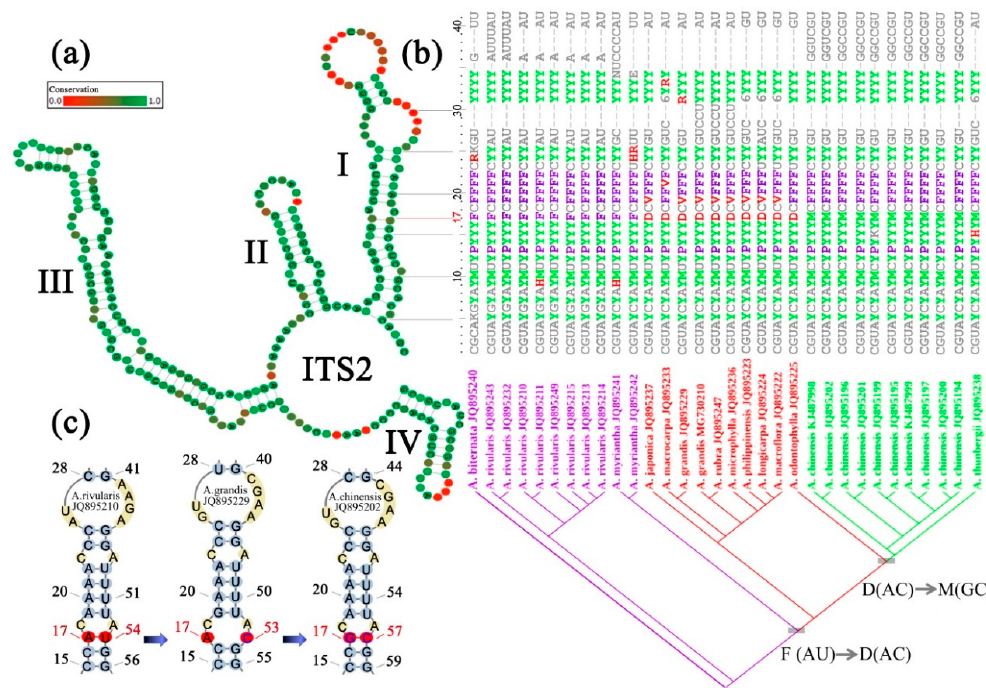
Figure 2. Transformation, visualization and optimization of compensatory base change in ITS2 secondary structure. ( a ) An ITS2 consensus secondary structure derived from closely related species of Astilbe . The four stems are labelled I–IV. Degree of site conservation over the entire alignment is displayed in colored grades from green (conservative) to red (variable). ( b ) A transformed coding matrix of sequence-structure information from portion of ITS2 stem I region. Base-pair information of ITS2 secondary structure ( a ) is coded and merged into a single character by using a modified 28-symbol coding matrix [40], wherein characters involved in CBC (compensatory base change) and hemi-CBC substitutions are highlighted in di ff erent colors, i.e., UA(P)-UG(R)-CG(Y), UA(P)-CA(H)-CG(Y), AU(F)-GU(V)-GC(M), AU(F)-AC(D)-GC(M). Character positions in the transformed matrix are corresponding to the ITS2 stem I one by one. Species of each sequence and their phylogenetic relationships are shown below. Base-pair states of site 17 are indicated using di ff erent colors in the matrix and are mapped and optimized on the tree to exemplify an unambiguous CBC process. ( c ) Representative sequence-structures showing di ff erent base-pair states of site 17. Numbers following a species name indicate GenBank accession numbers.